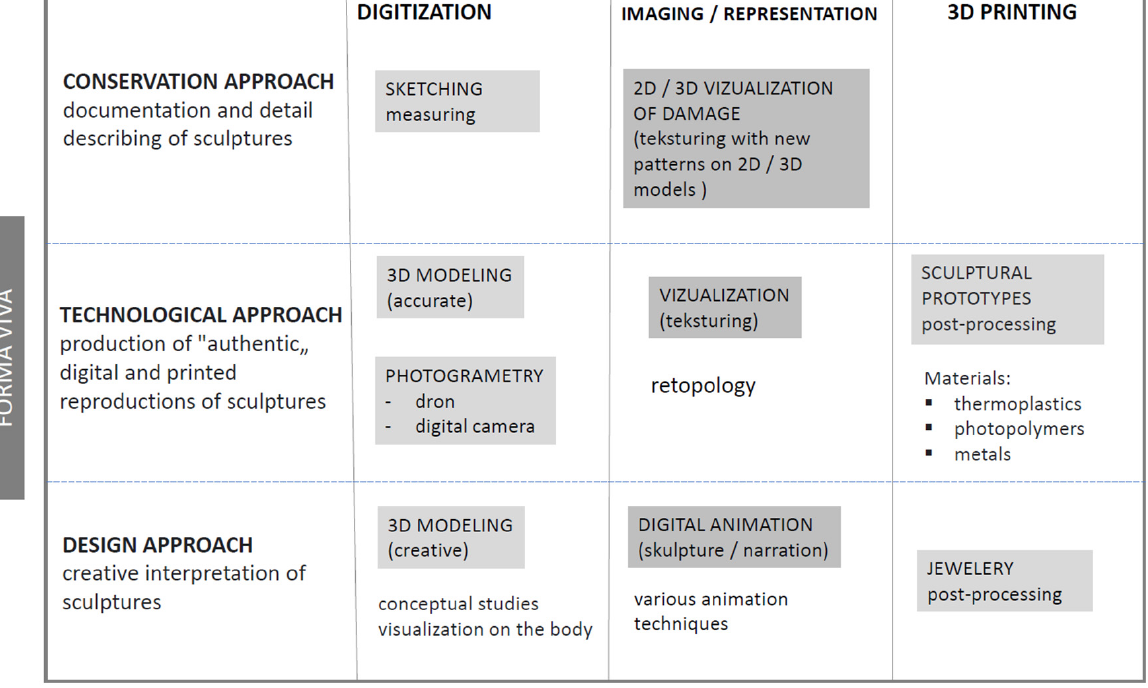
Figure 1. Schematic presentation of workflow of digital preservation, 3D reproduction and inter- pretation of Forma Viva sculptures from Kostanjevica na